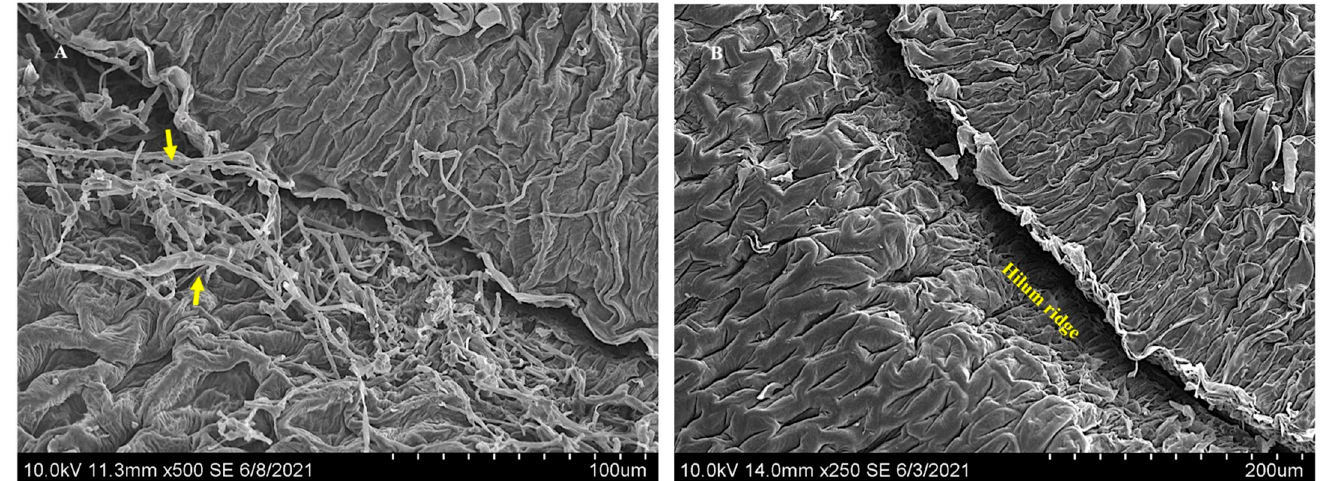
Figure 4. Scanning electron microscope images illustrating a topographical view of the hilum from Ipomoea carnea seeds; positive ( A ) and negative ( B ). Extensive network of mycelia observed on the positive hilum ridge indicated with arrows. No mycelia were observed in the hilum of negative seeds.